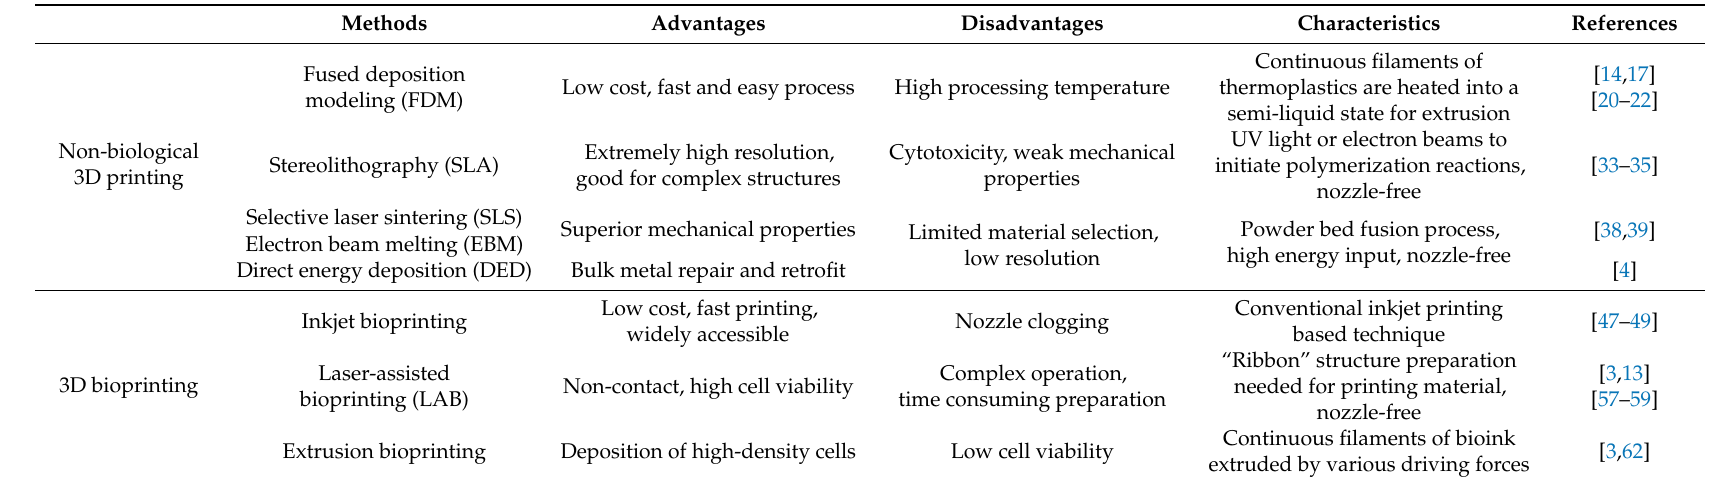
Table 1. Comparison of 3D printing